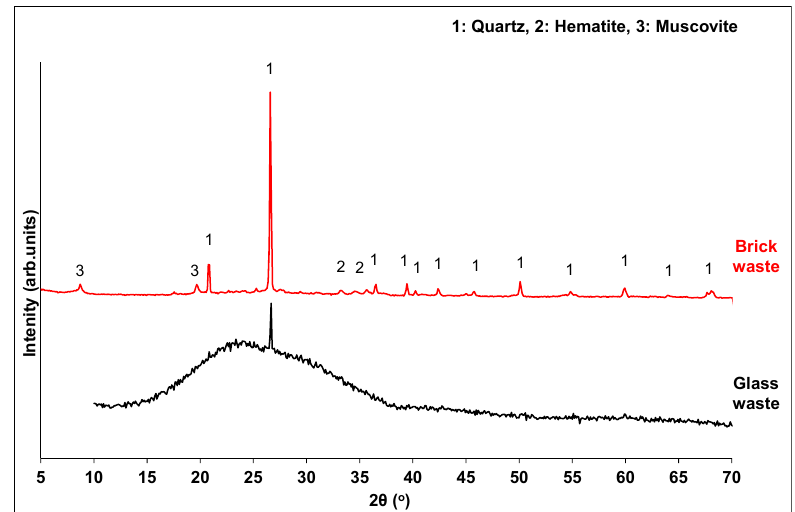
Figure 2. XRD pattern of waste precursors.